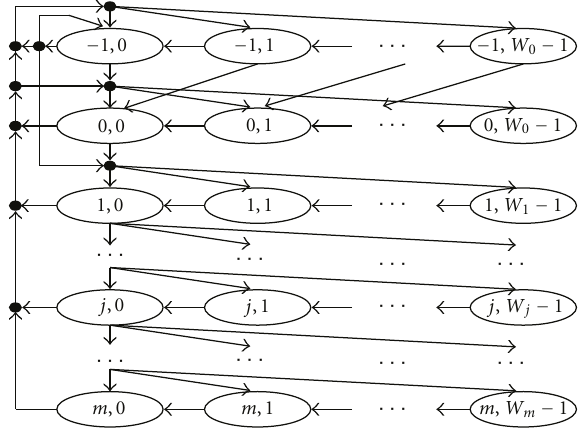
Figure 4: A Markov chain model for 802.11 DCF in unsaturated